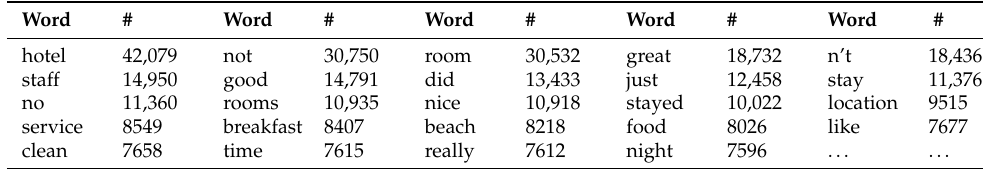
Table 2. List of the most used words in reviews.